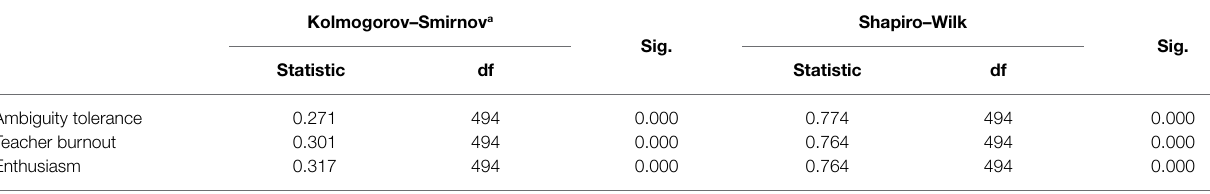
TABLE 2 | Test of normality.